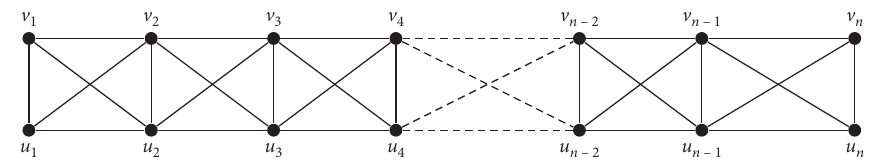
Figure 13: The diagonal ladder DL